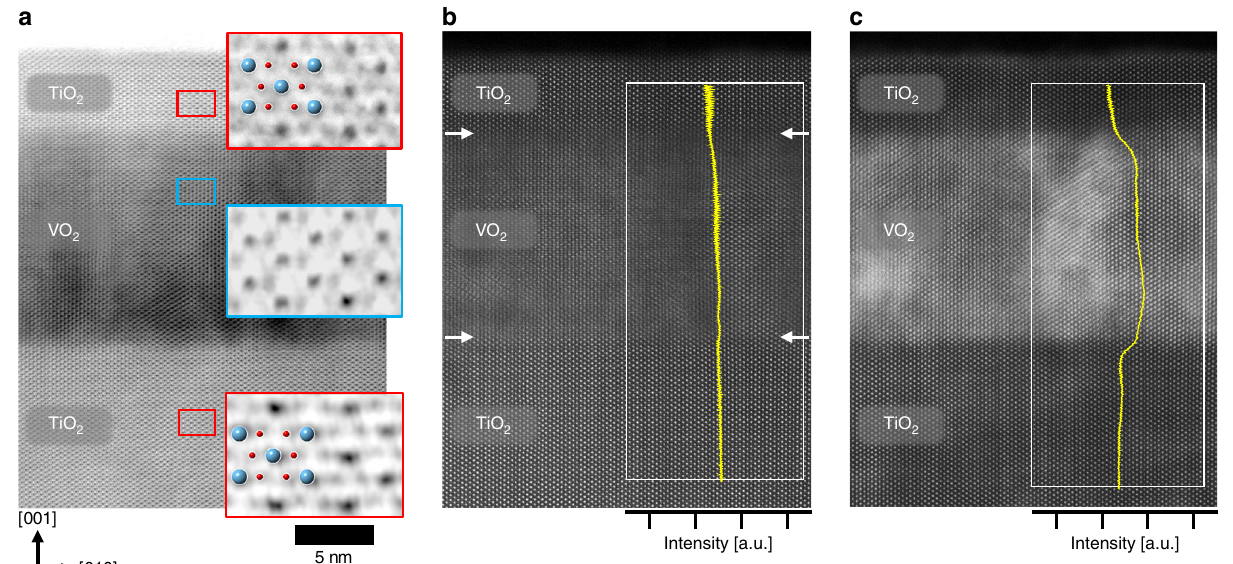
Fig. 2 Atomic-resolution analysis of TiO 2 /VO 2 /TiO 2 heterostructure. a ABF-STEM, b HAADF-STEM and c LAADF-STEM images of rutile TiO 2 epitaxial fi lm grown on VO fi cial template at T = 150 °C with [100] zone axis (scale bar = 5 nm). The sensitivity of ABF technique to light-weight atoms 2 sacri G enables observation of oxygen atoms along the [100] zone axis. Note that the regular pattern from TiO 2 epitaxial fi lms (top red square in a ) was identical to that from TiO 2 substrates (bottom red square in a ), indicating an identical atomic arrangement of fi lms with single crystals by epitaxial growth without oxygen defects. On the contrary, the oxygen-de fi cient region was observed in the sacri fi ced VO 2 template near the TiO 2 fi lm (blue square in a ). While almost-uniform HAADF contrast was observed across the heterostructures due to similar cation atomic weight across the heterostructures ( b ), a noticeable strain- fi eld-induced LAADF contrast was observed in VO 2 templates ( c ) sandwiched between TiO 2 fi lms and substrates. Yellow lines in b and c are the contrast-intensity pro fi les of the HAADF and LAADF images from the white rectangular